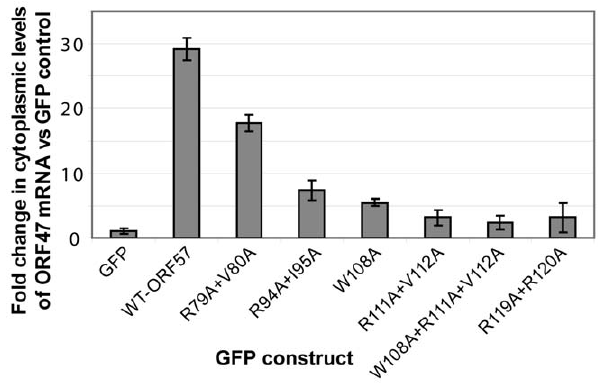
Figure 8. Perturbing the ORF57-REF/Aly interaction with point mutations decreases cytoplasmic accumulation of viral mRNA. 293T cells were transfected with the pORF47 reporter mRNA construct and the vectors containing wild type ORF57 or its mutants, and RNA was isolated from cytoplasmic fractions. The mutations probed residues from REF binding site, as well as from its vicinity. qRT-PCR was performed and data for mRNA reporter plus ORF57-transfected cells normalised against cells transfected with reporter in the presence of GFP. A DD cT method was applied to determine the relative levels of reporter mRNA between samples. Point mutations of ORF57 residues implicated in direct interaction with REF, and reducing its binding, all caused significant decrease in cytoplasmic accumulation of viral